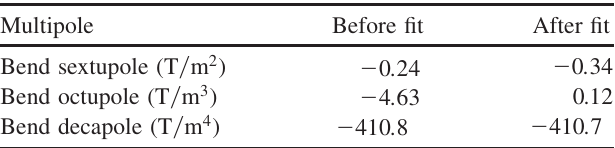
TABLE II. Variation of the systematic multipolar components of the main dipole after the